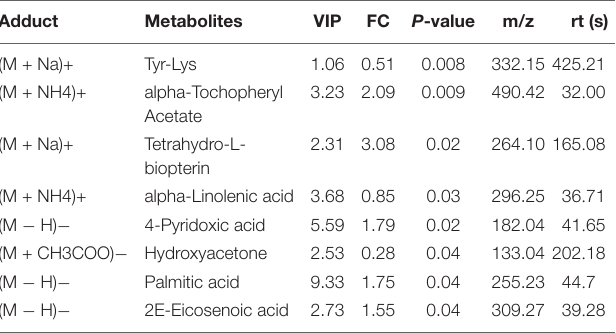
TABLE 1 | Identified significant different metabolites from control and Enterotoxigenic Escherichia coli (ETEC) groups under positive and negative ion model a .